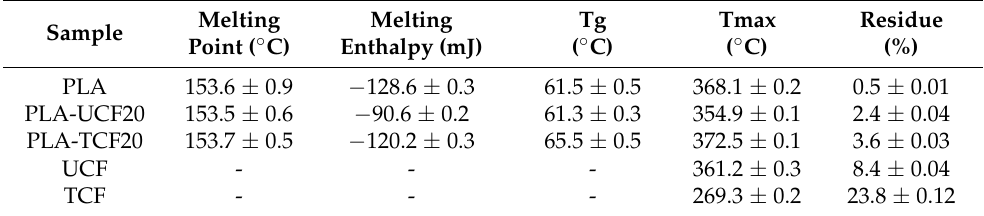
Table 3. Thermal properties of films and